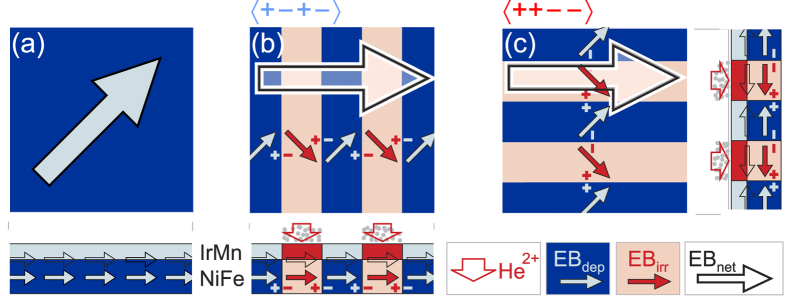
Ir23Mn77(7 nm)/Ni81Fe19(50 nm) sample structure and lateral state of exchange bias for (a) an as-deposited (dep) homogeneous state of exchange bias, (b) a head-to-tail-to-head-to-tail (〈+ − + −〉) and (c) the alternating head-to-head-to-tail-to-tail (〈+ + − −〉) unidirectional anisotropy configuration after local He-ion irradiation (irr) in an applied magnetic field aligned perpendicular to the as-deposited direction of exchange bias. The directions of exchange bias for the as-deposited EBdep, the irradiated regions EBirr, and the net directions of resulting exchange bias EBnet are indicated.